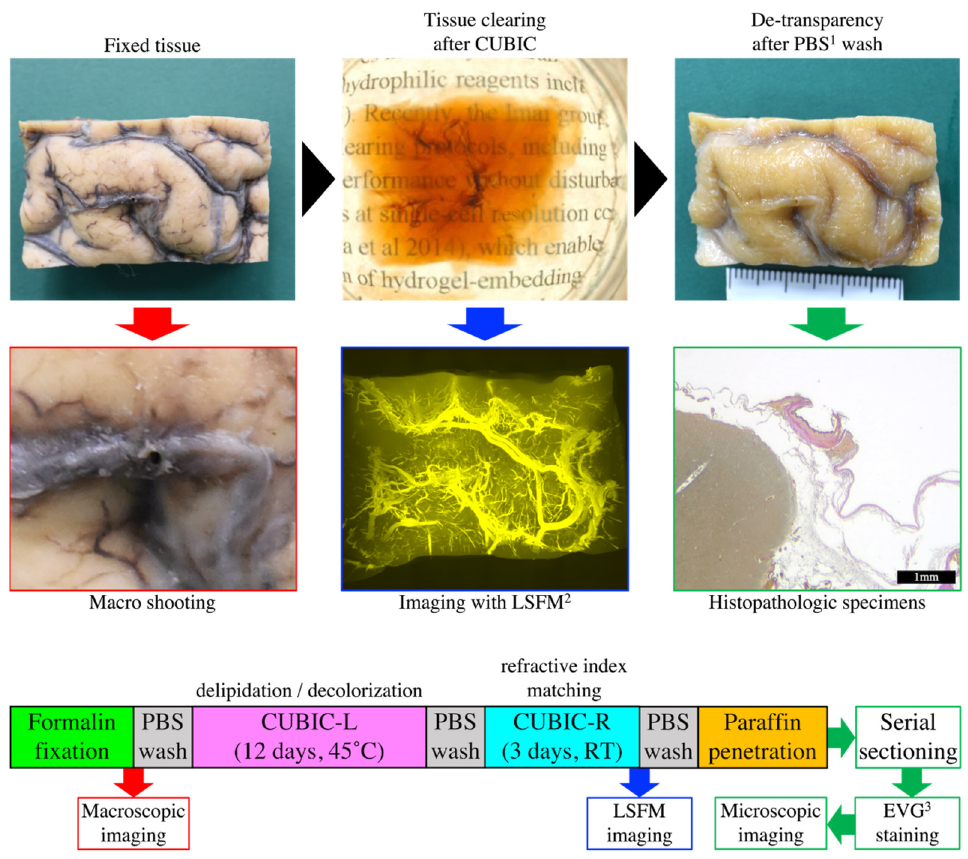
Figure 1. The procedural flow from tissue-clearing to histopathological analysis using the CUBIC method. 1 Phosphate-buffered saline, 2 Light-sheet fluorescence microscopy and 3 Elastica van Gieson.